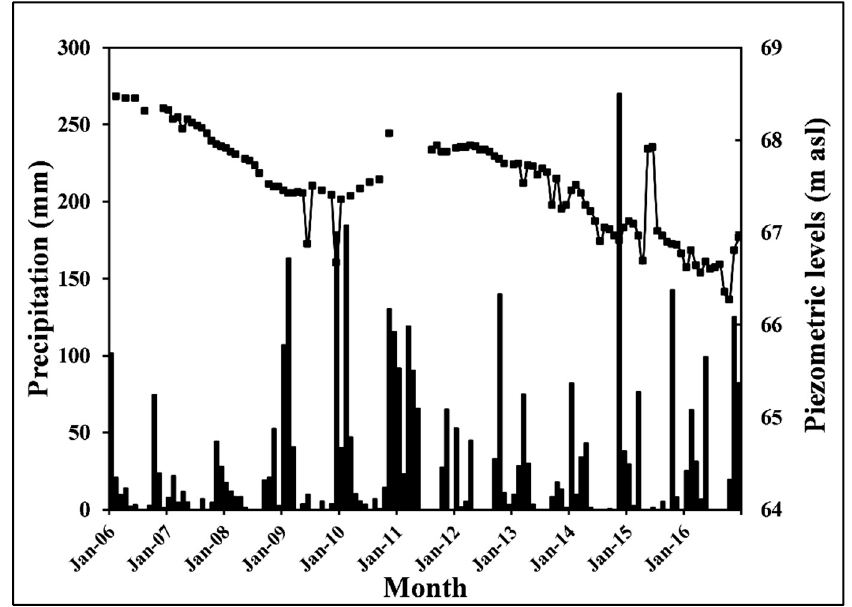
Figure 1. Groundwater level changes from 2006 to 2016.